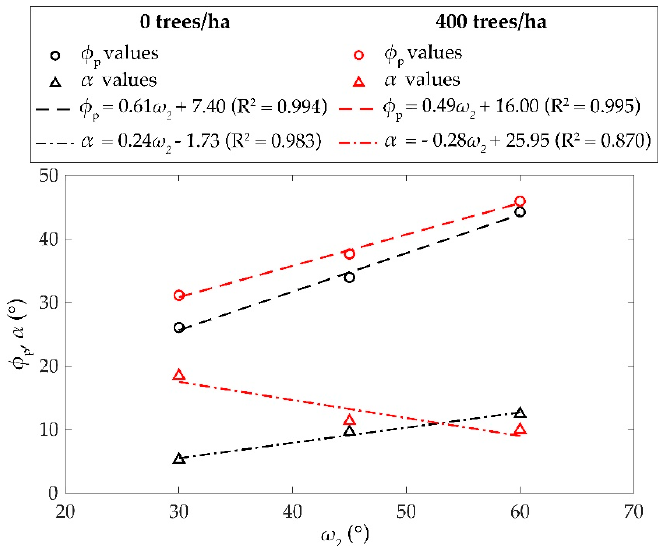
Figure 8. Effect of forest on the variation of angles φ p and α as a function of slope inclination ω 2 . Spherical blocks of unitary volume are considered here.